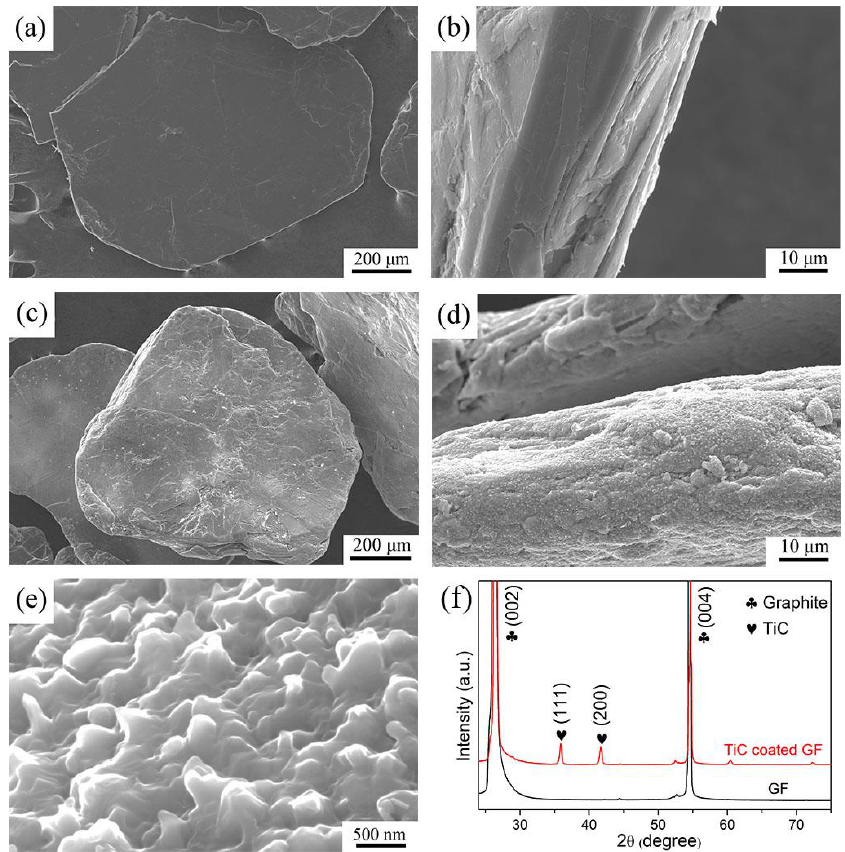
Figure 2. SEM images and XRD patterns of raw graphite flake (GF) and TiC-coated GF: ( a ) raw GF, ( b ) the edge of raw GF, ( c ) TiC-coated GF, ( d ) the edge of TiC-coated GF, ( e ) the surface morphology of coating layer, ( d ) XRD patterns of raw GF and TiC-coated GF.